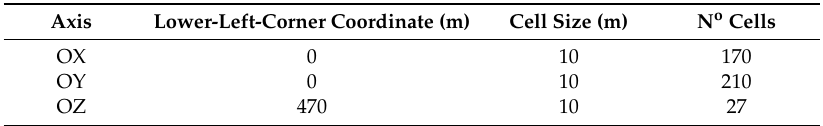
Table 3. Final grid (10 m × 10 m × 10 m)